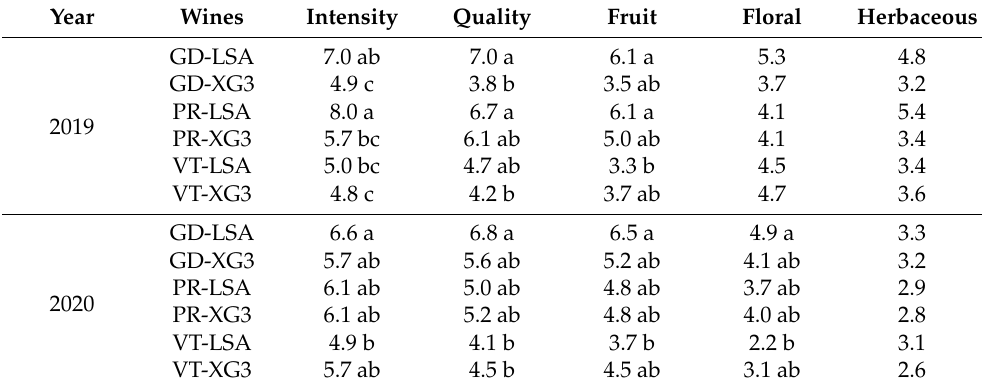
Table 5. Aroma descriptors intensity of Treixadura wines from Priorato de Razamonde (PR), O’Ventosela (VT) and Gandarela (GD) wineries obtained with different yeasts in 2019 and 2020